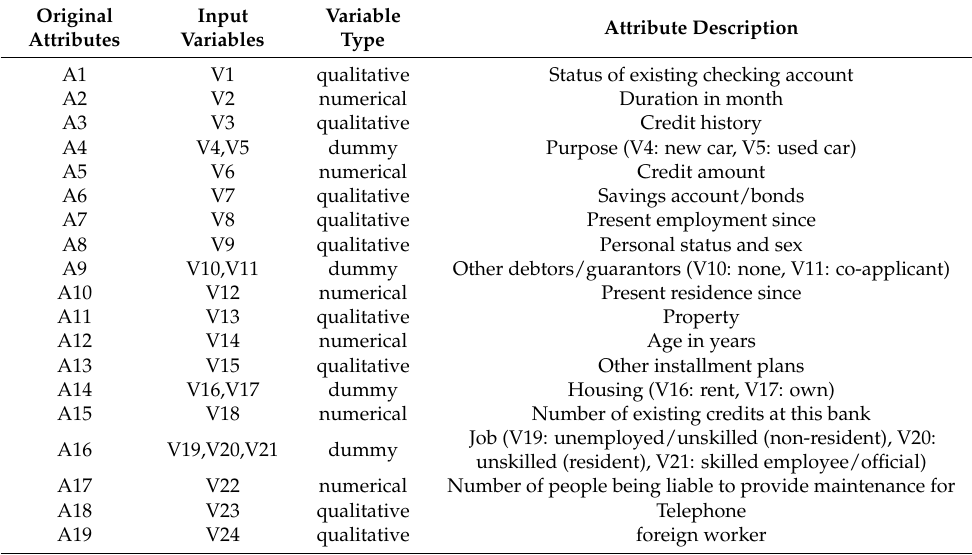
Table 1. Input variables of German data